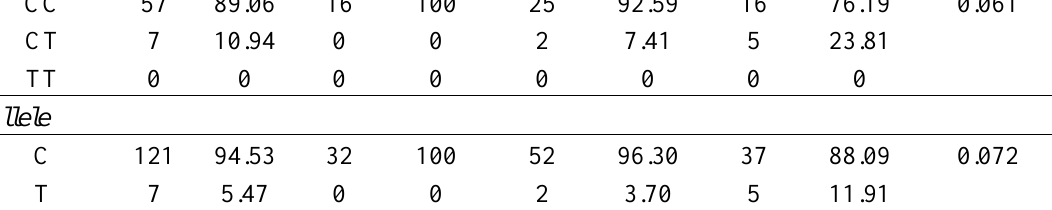
Figure 3. Pairwise comparison subsequent to one-way ANCOVA showed that subjects homozygous for the G-allele of the rs1761667 polymorphism exhibited a 5-fold lower threshold for oleic acid than homozygous AA subjects ( p = 0.041, Fisher LSD test) (upper graph). No changes associated with the rs1527483 polymorphism were found (lower